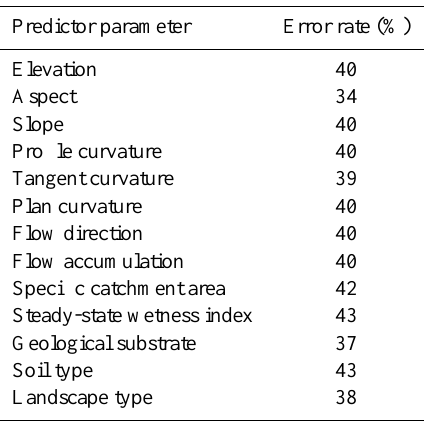
Table 4. Missclassification error rates (%) when excluding each parameter one at a time from the potential pool of predictor param-